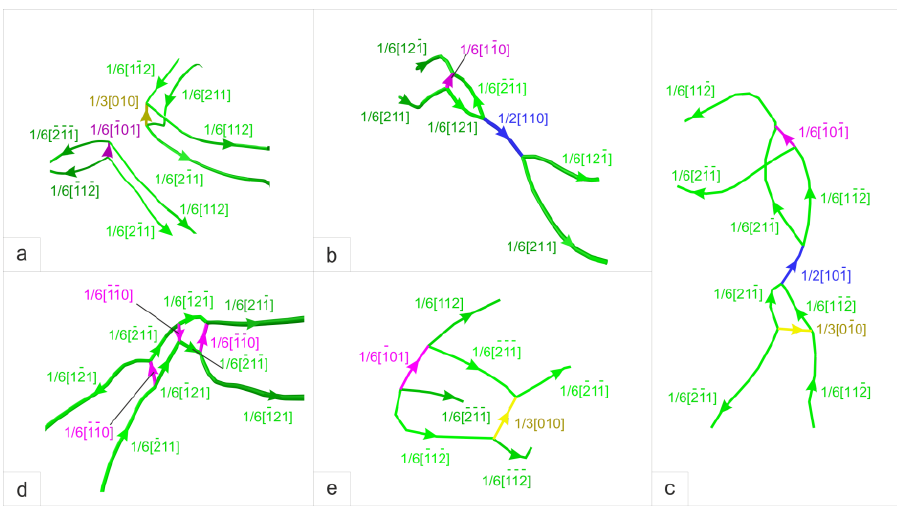
Figure 6. The structure of low-mobile dislocation complexes from Shockley dislocations and other dislocations such as ( a ) stair-rod, Hirth; ( b ) stair-rod and perfect; ( c ) Stair-rod, Hirth, and perfect; ( d ) few stair-rods; and ( e ) stair-rod and